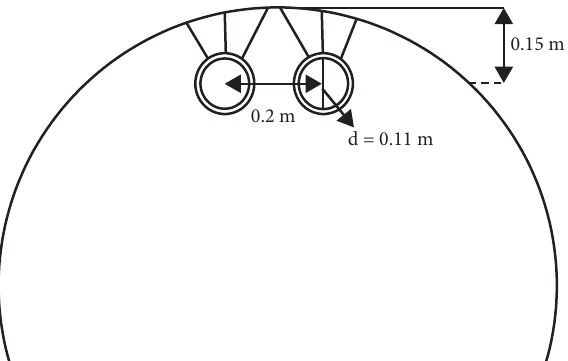
Figure 12: Position of jet